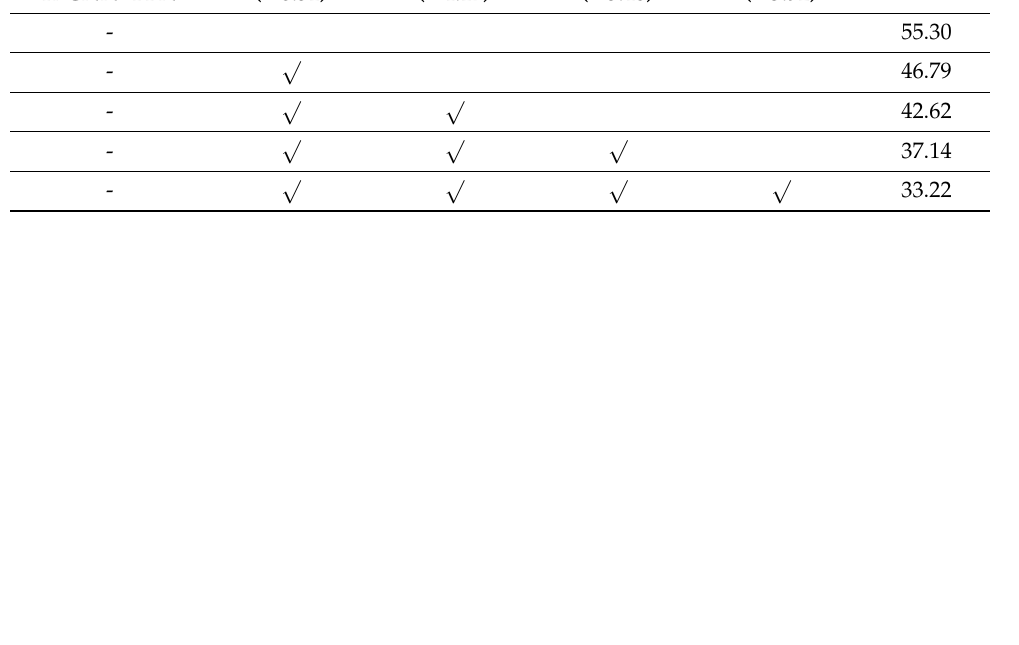
Table 2. Influence of each component of our proposed method on the Caltech heavy occlusion subset.